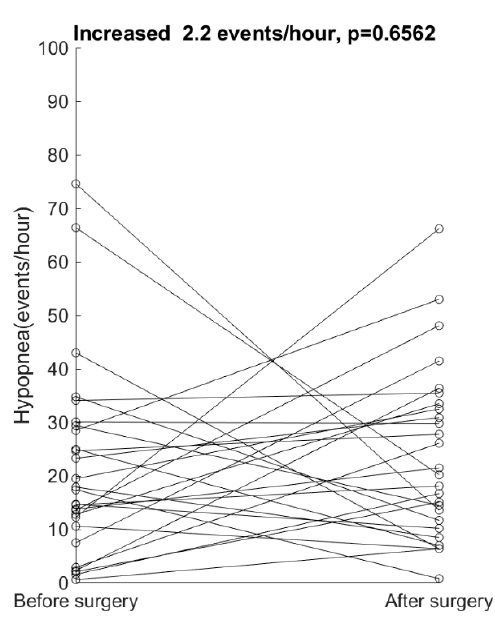
Figure 3. Individual hypopnea index did not reveal a significant change after the surgery.